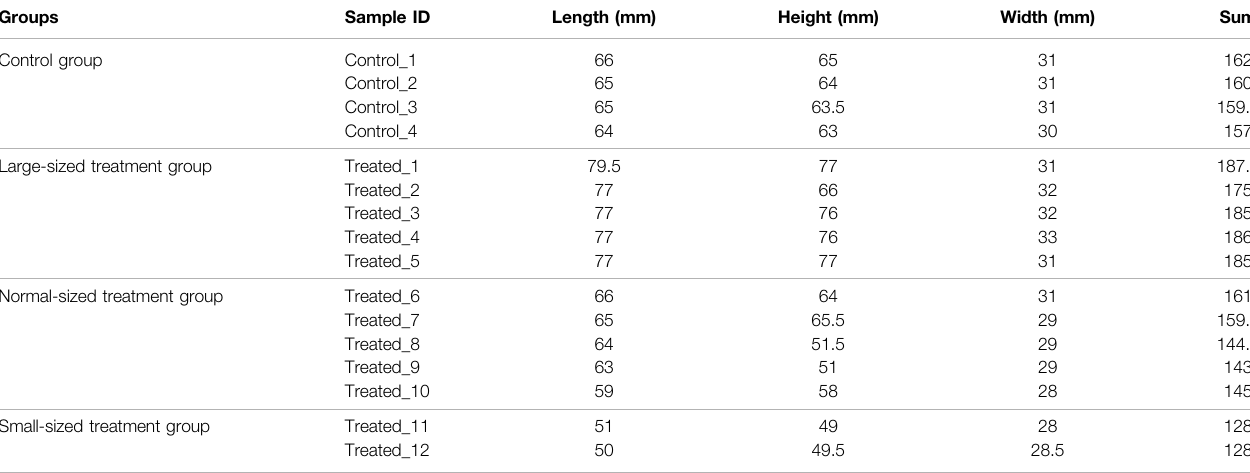
TABLE 1 | Sizes of the sequenced individuals in the control and treatment